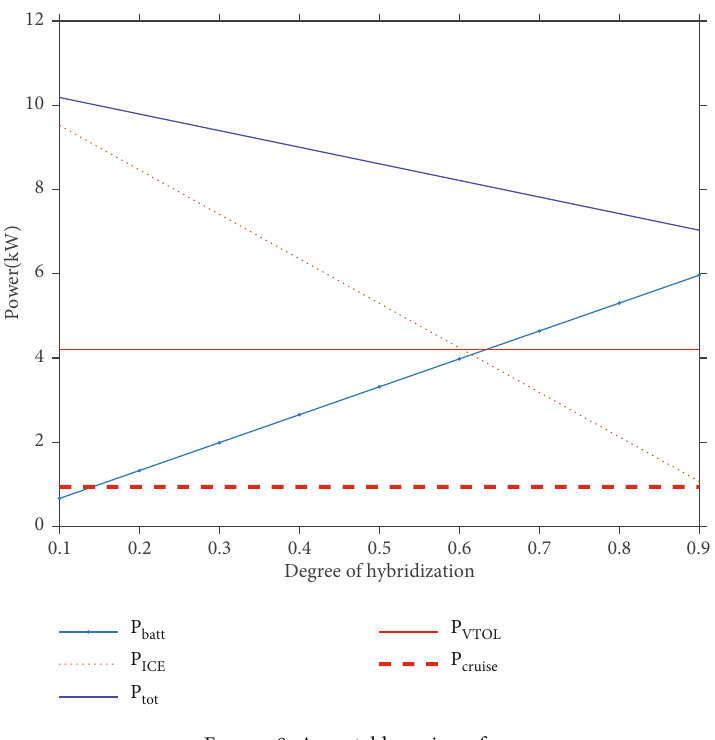
Figure 8: Acceptable region of γ .